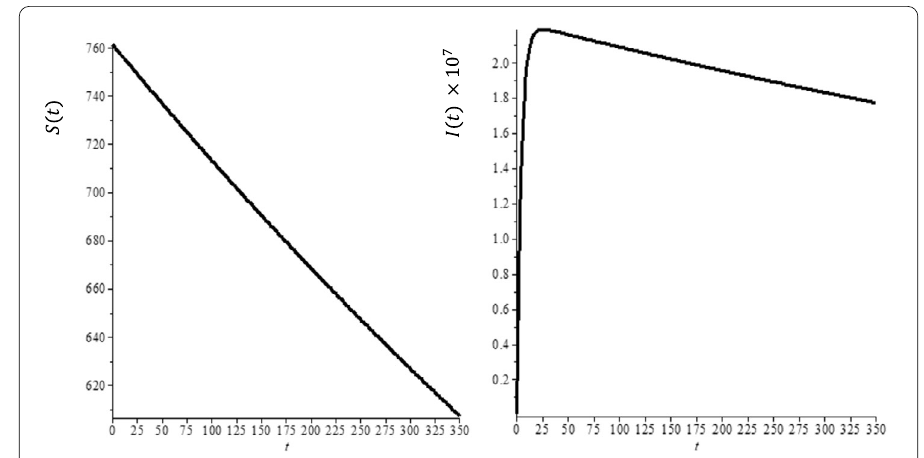
Figure 1 Time development of susceptible ( a ) and infected ( b ) individuals for integer of order derivatives, b = 100 and R 0 =